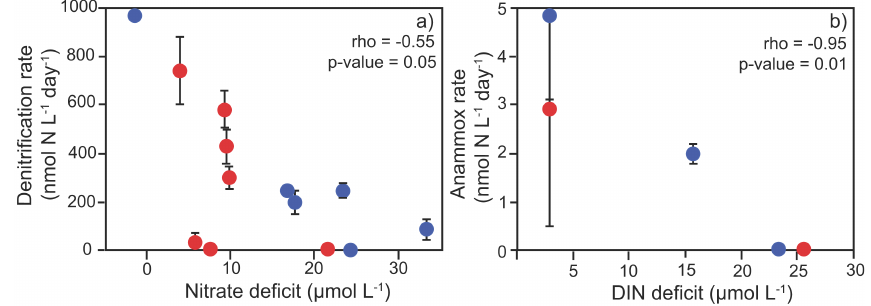
Fig. 7. Relationships between potential denitrification rate and NO − deficit (a) , and potential anammox rate and total DIN deficit (b) in 3 hydrothermal vent fluids of the Juan de Fuca Ridge. See text for details. Hydrothermal vent fluids sampled from Axial Volcano and the Endeavour Segment are indicated in blue and red, respectively. Spearman’s rank correlation coefficient ( ρ ) and p-value are shown. Reported errors for denitrification and anammox rates were derived from standard errors of the regression